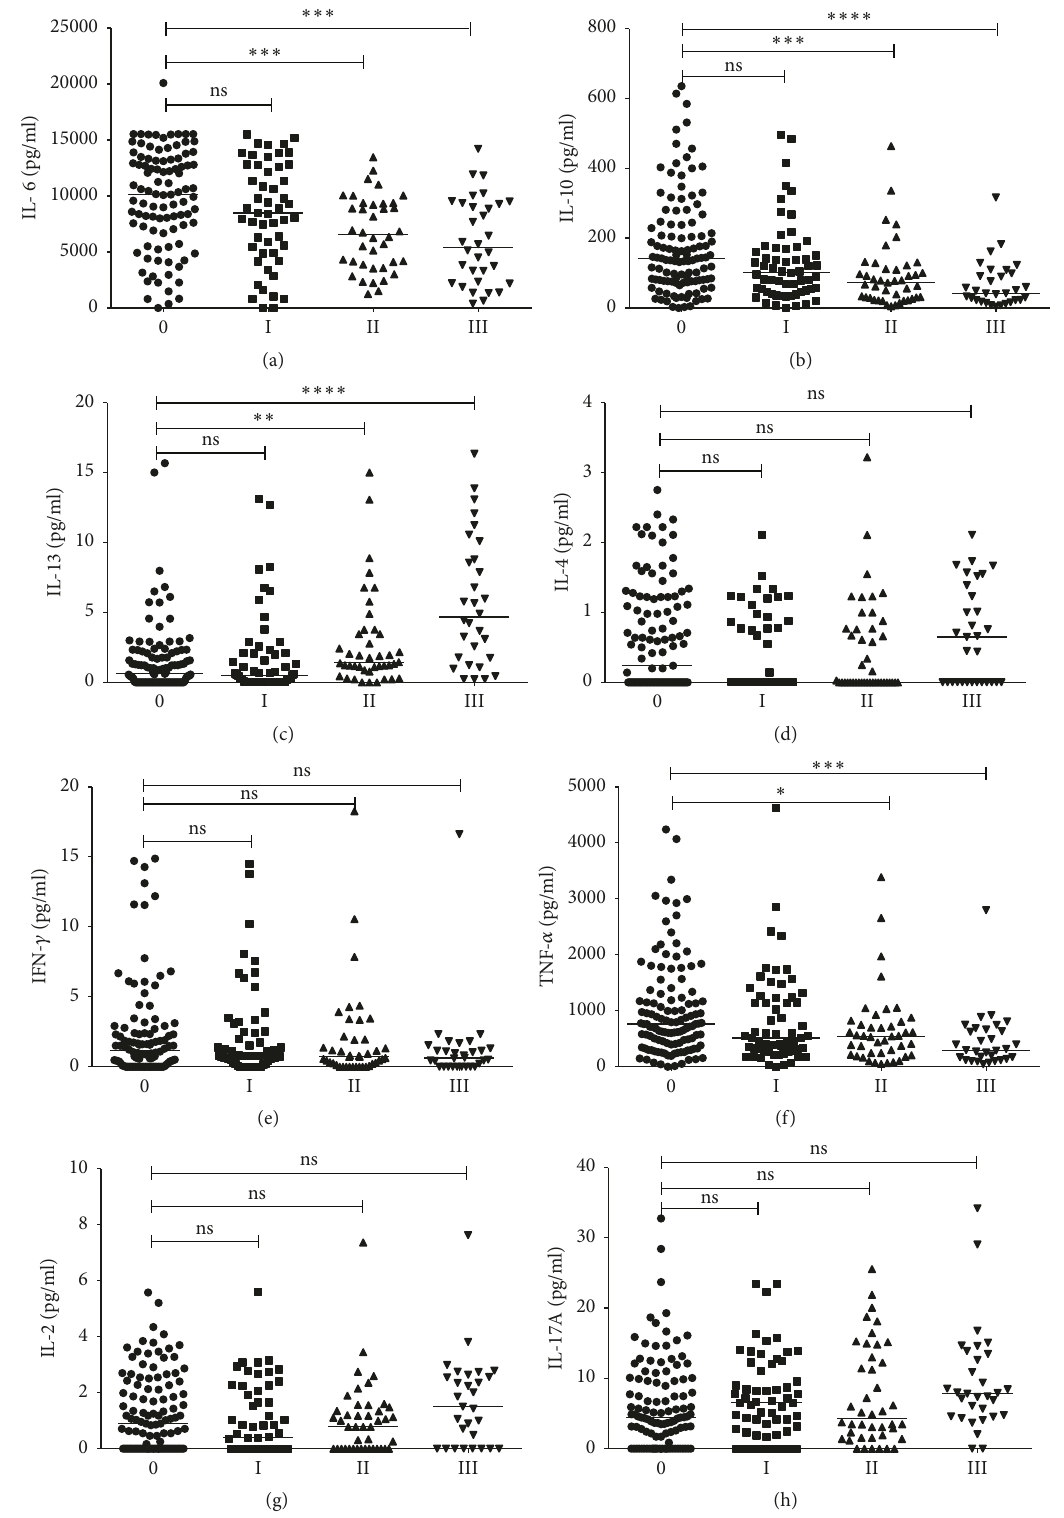
Figure 1: Cytokine levels in relation to degree of fibrosis. Median differences between Group 0 (control) and each of the three groups were determined using Dunn’s test for multiple comparisons. Group 0 (infected with no fibrosis), Group I (infected with mild fibrosis), Group II (infected with moderate fibrosis), and Group III (infected with severe fibrosis). The significant level was set at ≤ 0.05 for a two-sided test. ∗ 𝑝 ≤ 0.05 , ∗∗ 𝑝 ≤ 0.01 , ∗∗∗ 𝑝 ≤ 0.001 , and ∗∗∗∗ 𝑝 ≤ 0.0001